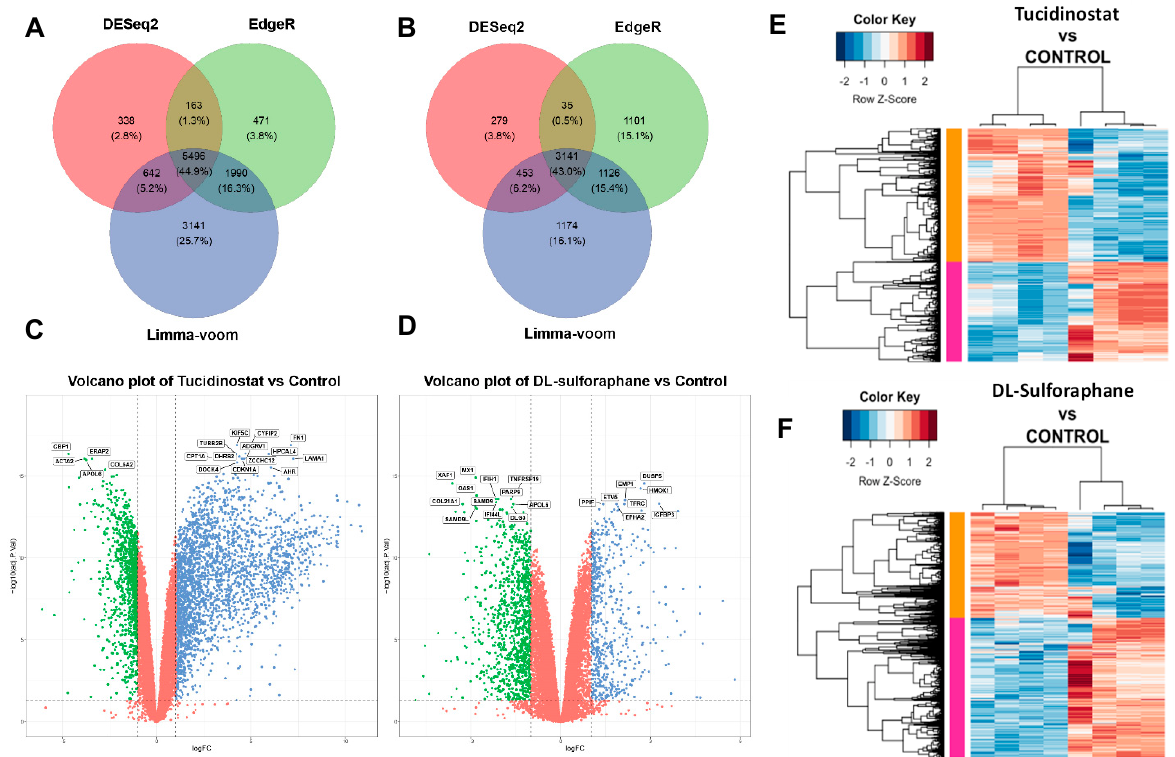
Figure 6. Treatment with Tucidinostat and DL-sulforaphane sculpts the transcriptome of uLMS cells. Venn diagrams to demonstrate the DEGs identified by three methods of Limma + voom, edgeR and DESeq2 at Adjusted P -value cut off 0.05 and − 1.5 > log2FC > 1.5 for ( A ) Tucidinostat vs. Control ( B ) DL-sulforaphane vs. Control. Volcano plots of the gene expression profiles of ( C ) Tucidinostat vs. Control ( D ) DL-sulforaphane vs. Control. The blue points represent upregulated genes, and the green points represent downregulated genes. The vertical dotted black lines represent the log (FC) cutoff, and the horizontal black line represents the logarithmic transformed Adjusted P -value cutoff. ( E ) Heat map; Pearson correlation was used to cluster DEG (Tucidinostat vs. Control), which were then represented as a heatmap with the data scaled by Z score for each row. ( F ); Heat map. Pearson correlation was used to cluster DEG (DL-Sulforaphane vs. Control), which was then represented as a heatmap with the data scaled by Z score for each row. DEGs: differentially expressed genes, FC: fold-change.